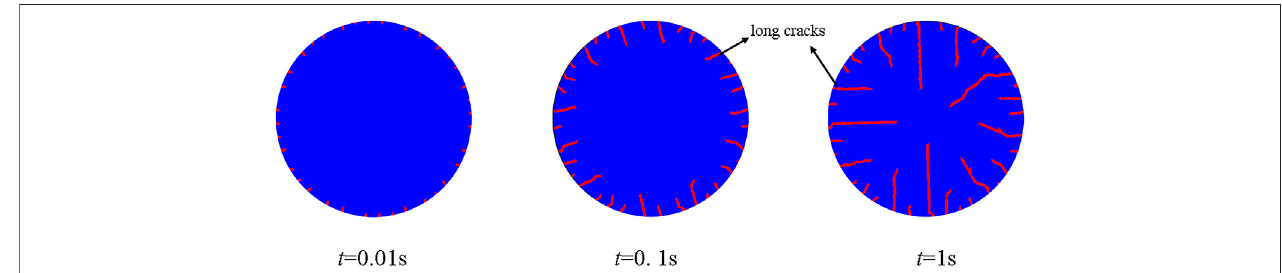
FIGURE 7 | Thermal shock-induced crack initiation and propagation process of circular Al 2 O 3 under the initial temperature of 500 ° C. Thermal shock behavior of rectangular Al 2 O 3